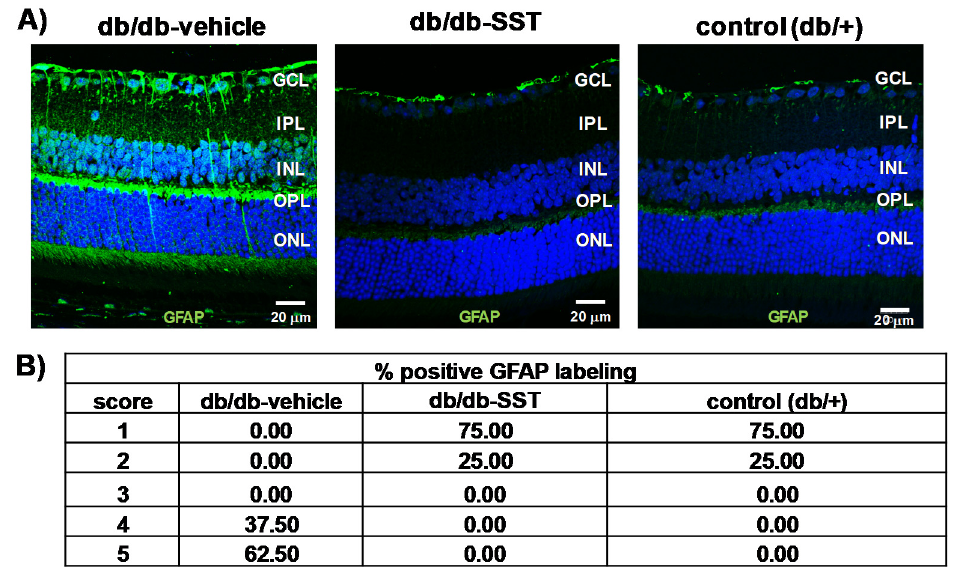
Figure 1. E ff ect of topical somatostatin (SST) administration on glial activation in db / db mice. ( A ) Comparison of GFAP immunoreactivity (green) in the retina among representative samples from a diabetic mouse treated with vehicle, a diabetic mouse treated with SST and a non-diabetic mouse. Nuclei were labeled with Hoechst (blue). ONL: outer nuclear layer; INL: inner nuclear layer; GCL: ganglion cell layer. Scale bars, 20 µ m. ( B ) Quantification of glial activation based on the extent of GFAP staining. N: 10 mice per